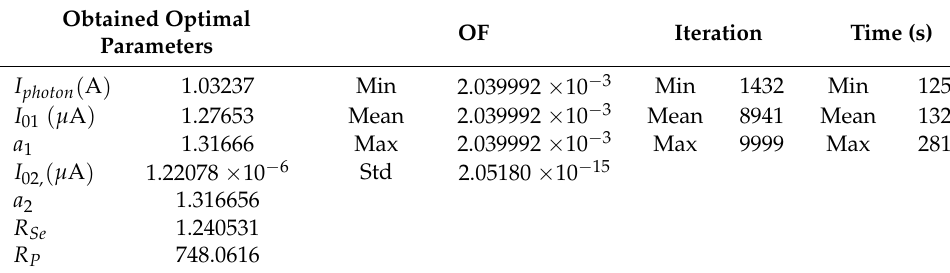
Figure 10. IAE for SDM and DDM, PV module. Table 8. Obtained statistical results for the DDM PV module. Obtained Optimal Parameters